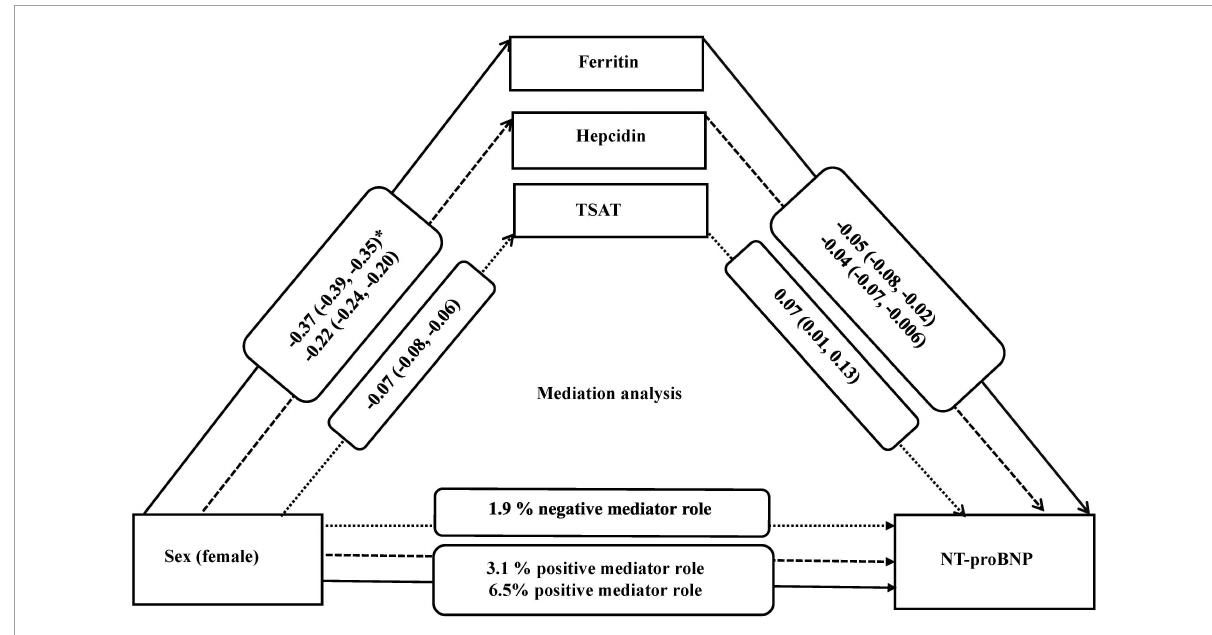
FIGURE1 Mediation analysis for association of sex with NT-proBNP and the role of iron biomarkers, adjusted for (covariates) age, BMI, smoking, and alcohol use. *Beta (95% confidence interval). All iron biomarkers were log transformed. NT-proBNP indicates N-terminal pro B-type natriuretic peptide; TSAT, Transferrin saturation; and BMI, body mass